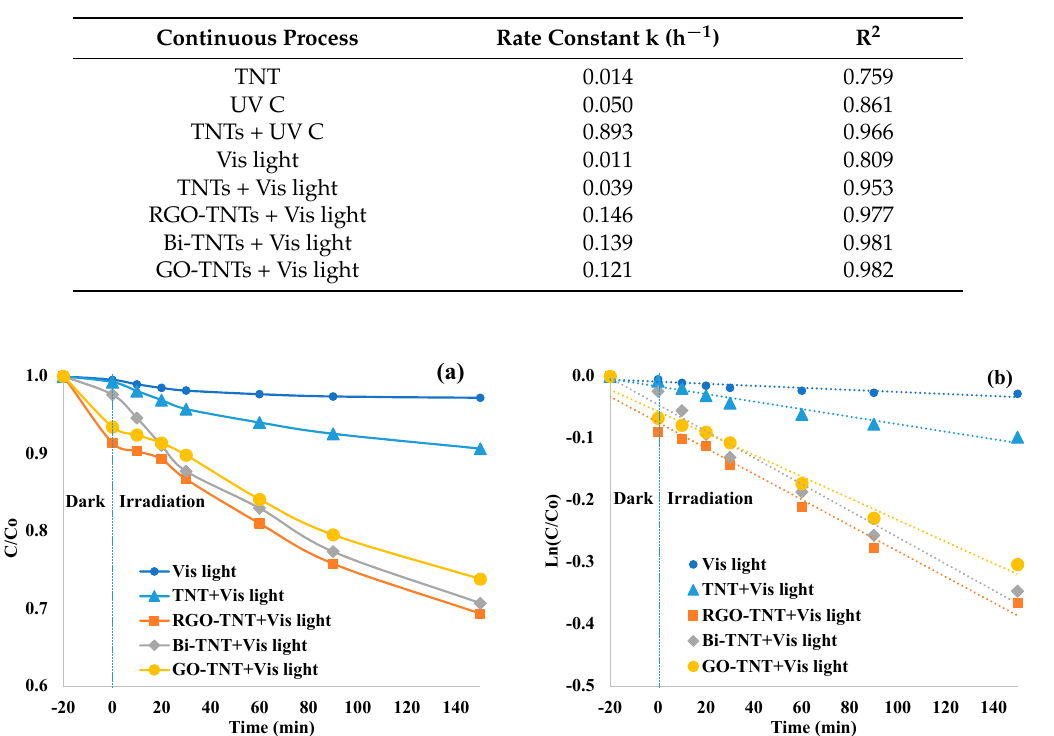
Table 2. First order rate constants k and the R 2 values.